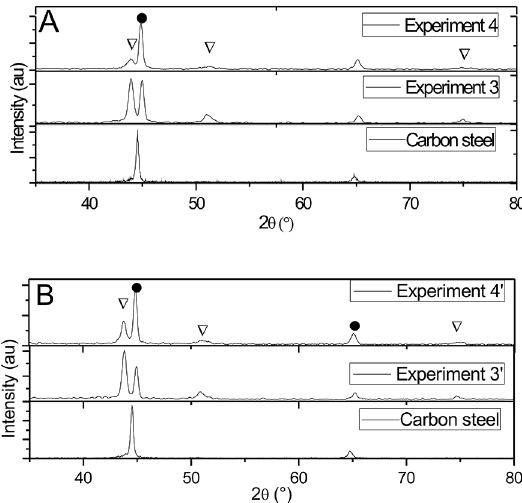
Figure 4. X-rays diffractograms of the Cu-Co coating produced using (A) DC and (B) SPC. Legend: diffraction lines related to CuCo ( ▽ ) and Fe (●)